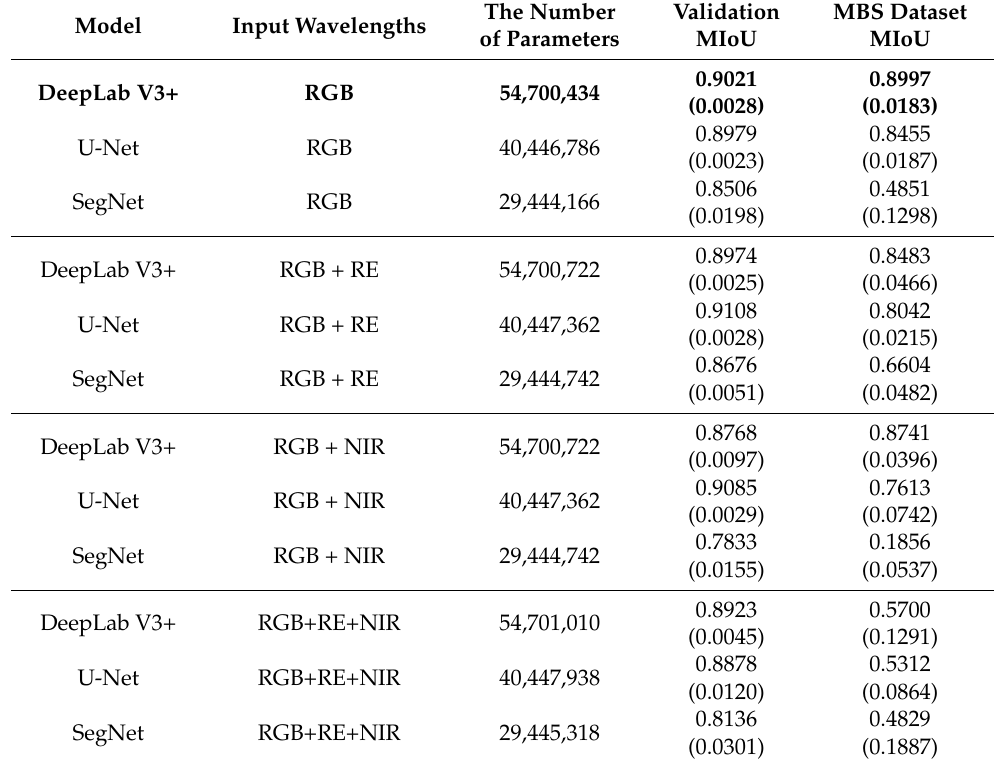
Table 1. Comparisons of model’s performance on the validation and the MBS dataset. The best performance of MIoU is boldfaced . Standard deviations are given in